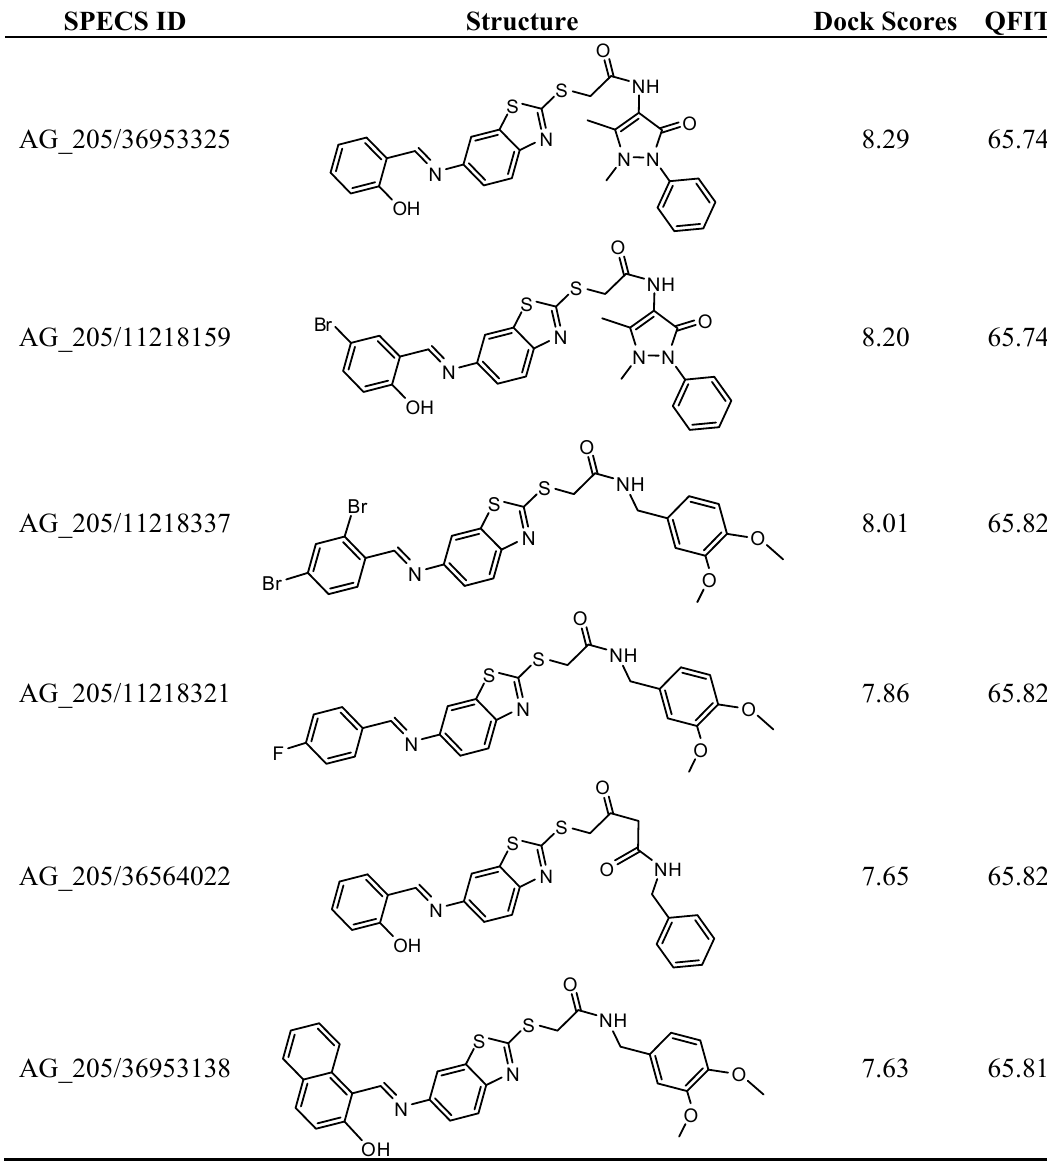
Table 3. Chemical structures of the hit compounds and their dock scores and QFIT